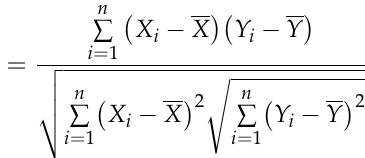
Table 5. Fitting results for the pull-off